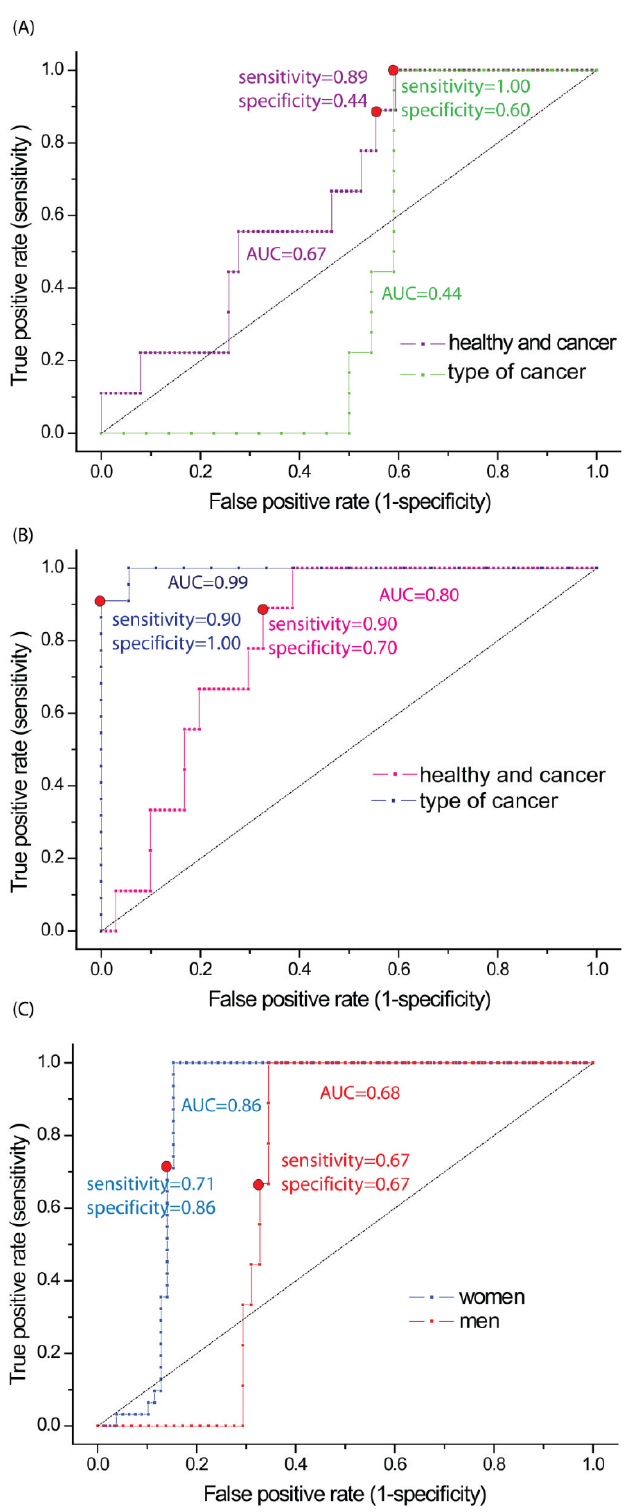
Figure 5. The ROC curve with the optimal operating point (red circle) for PCR method, calculated for non-cancerous vs. cancerous samples (green line) and squamous cell vs. adenocarcinoma samples (purple line) ( A ). For the PLS-DA method, calculated for the non-cancerous vs. cancerous samples (dark blue line) and squamous cell vs. adenocarcinoma samples (pink line) ( B ) and for the non-cancerous and cancerous samples for men (blue line) and women (red line) ( C ).